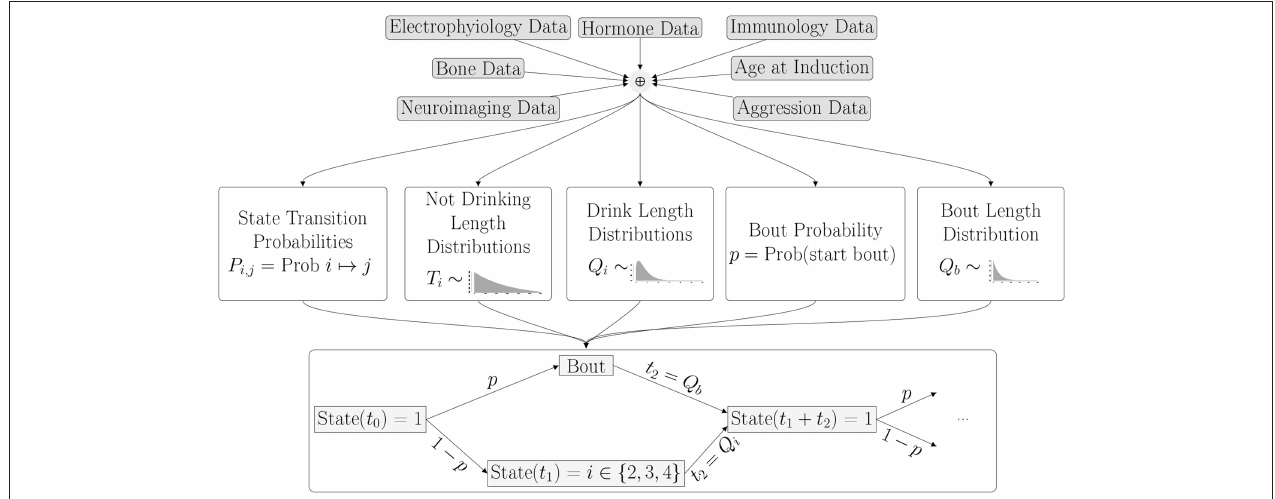
FIGURE 10 | In the next phase of the project, the parameters of the probability distributions will be estimated from an individual monkey’s set of features derived from physiological characteristics and measurements.